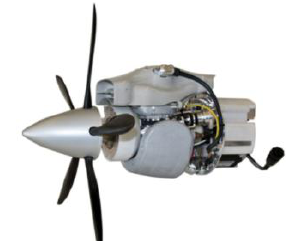
Figure 3: NW-44 multifuel internal combustion